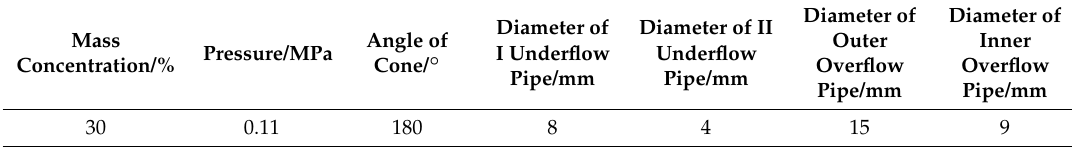
Table 3. The optimal parameter based on overflow fineness.